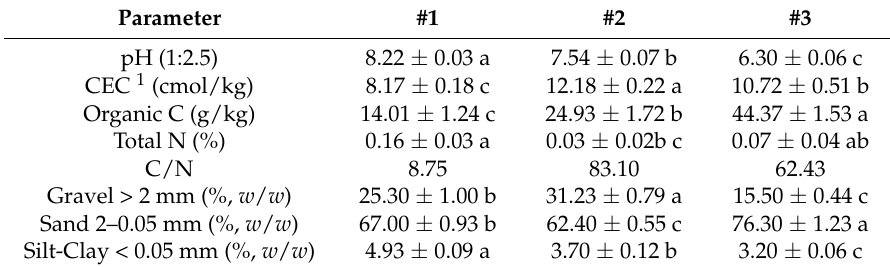
Table 3. Basic soil properties of the topsoil collected at three waste sites [20].